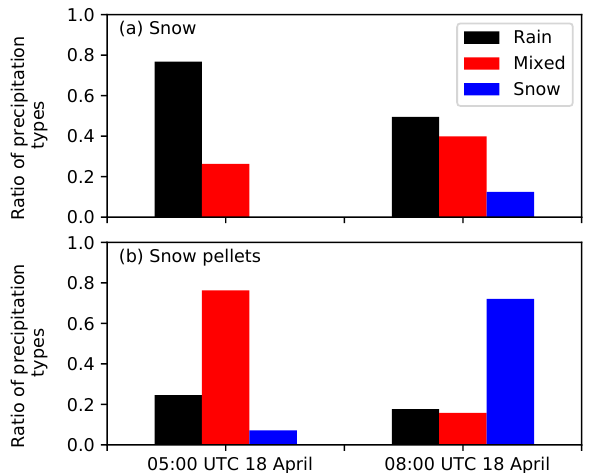
Figure 12. Ratio of precipitation produced at the surface by the one-dimension cloud model coupled to a bulk microphysics scheme (Sankaré and Thériault, 2016). The precipitation produced assum- ing (a) snow and (b) snow pellets falling through the melting layer ( T > 0 ◦ C) associated with two